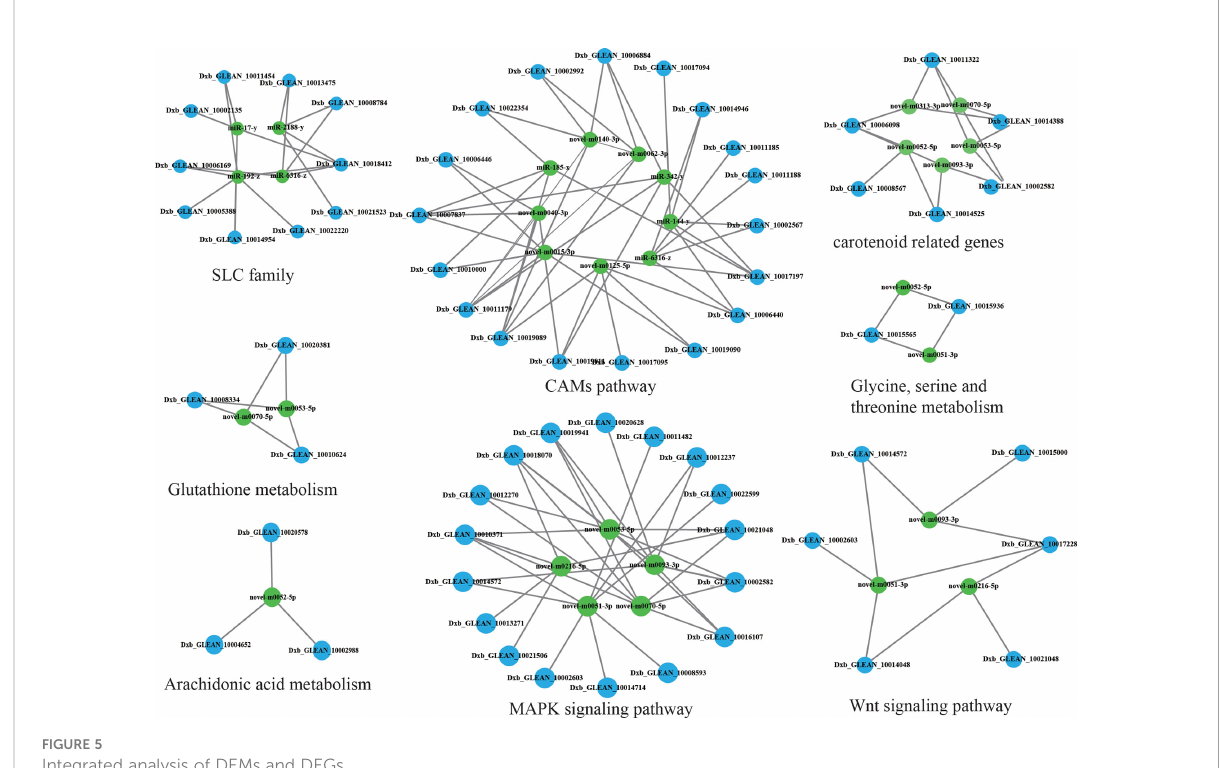
FIGURE 5 Integrated analysis of DEMs and